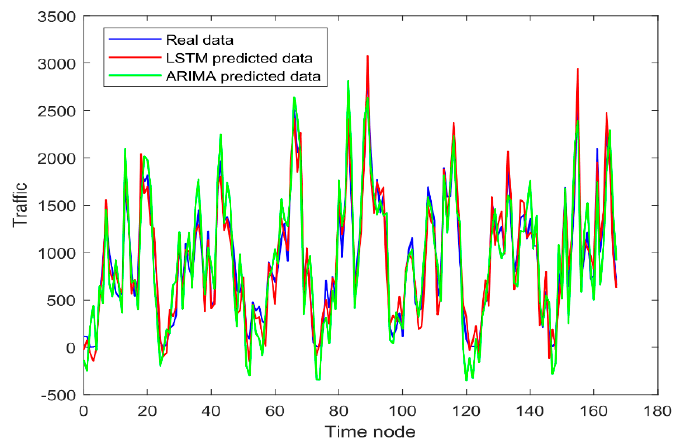
Figure 7. Traffic forecasting for BS Cell_000113.